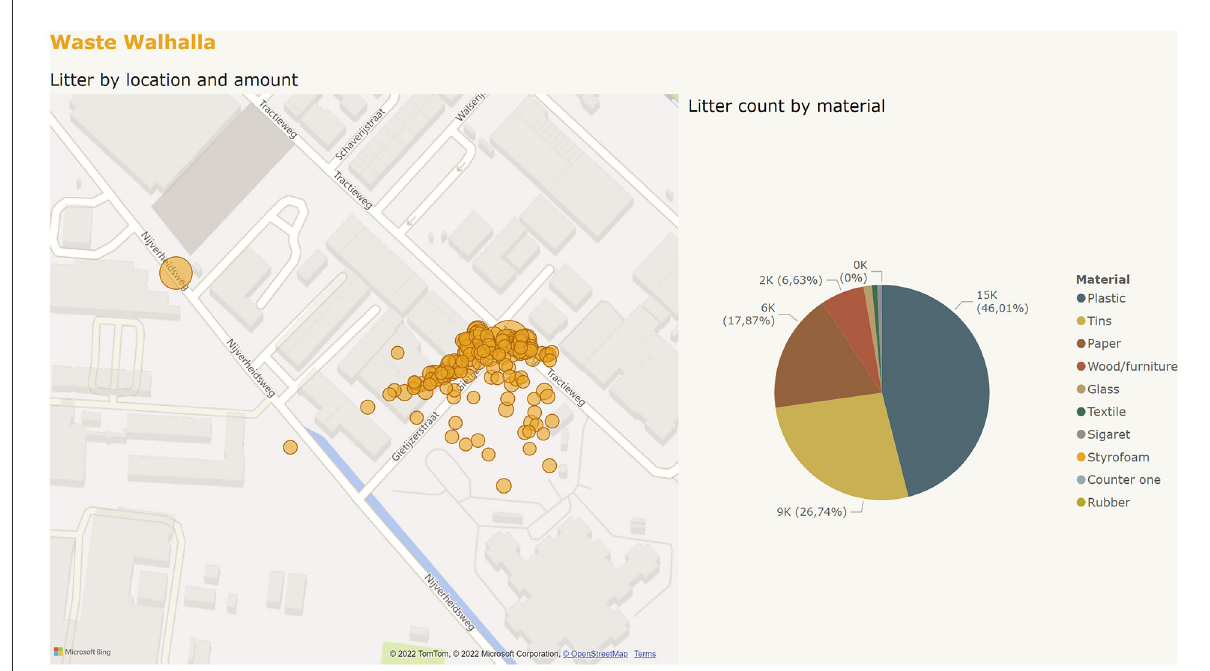
FIGURE6 The data collected by the group that went out to look for the geography of litter. This visualization was done by Ruth Schmidt.